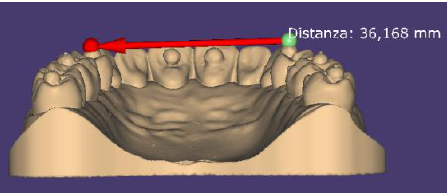
Figure 3. Example of contralateral measurement between premolars . Table 1. Measurement